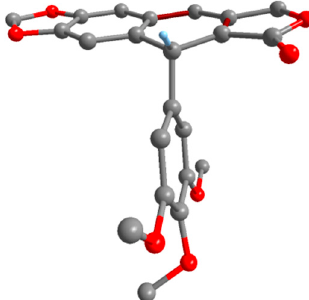
Figure 1. X-ray crystal structure of (+)- β - apopicropodophyllin ( 5 ), selected H atoms have been omitted for clarity.